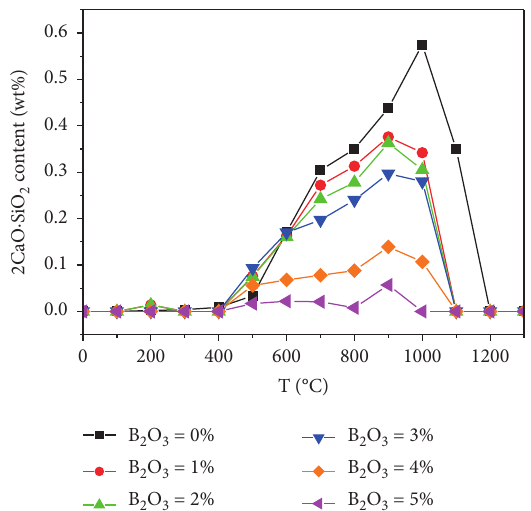
Figure 8: 2CaO · SiO 2 contents in the samples with different B 2 O 3